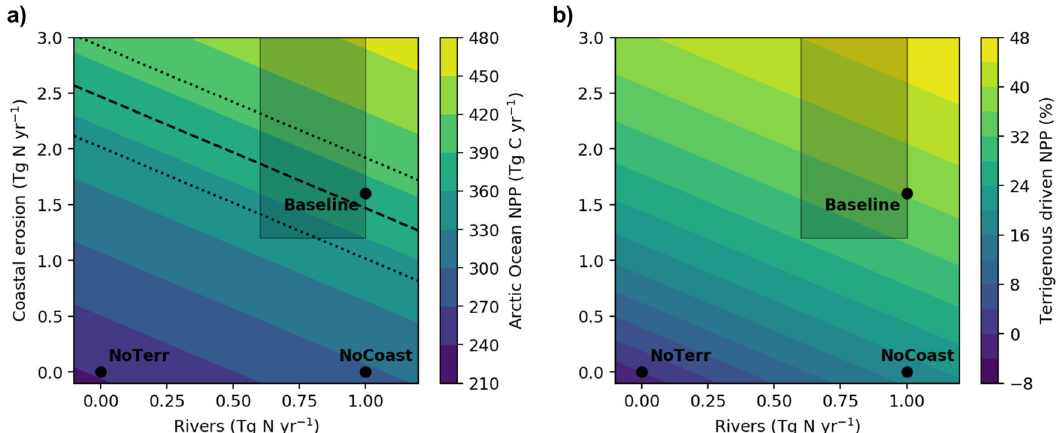
Fig. 4 Net primary production dependence of terrigenous nitrogen input. a simulated Arctic Ocean net primary production (NPP) and b part of NPP driven by terrigenous nitrogen input from rivers and coastal erosion. Simulated NPP in the Baseline, NoCoast, and NoTerr simulations are shown as black dots. The coloured shading is scaled proportional to the terrigenous nitrogen input. The grey shading indicates the possible range of terrigenous nutrient input available for NPP taking into account the remineralisation rate of terrigenous organic matter and the inclusion of missing sources of terrigenous nitrogen. Remote-sensing-based NPP derived from satellite observations of chlorophyll-a 6 (black dashed line) with uncertainties (dotted black line) are shown in a (excluding Nordic Seas and CAA that are mainly out of the area that we de fi ned as the Arctic